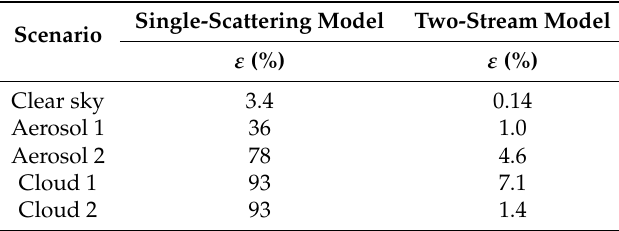
Table 2. Mean relative error ε for the low-stream models (single-scattering and two-stream models) compared with the multi-stream model for the O 2 A-band.